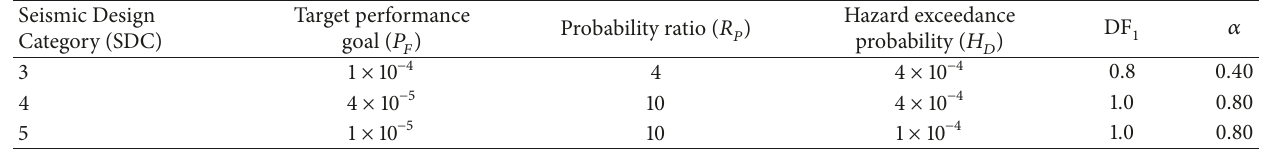
Table 2: Summary of earthquake design provisions of ASCE/SEI 43-05